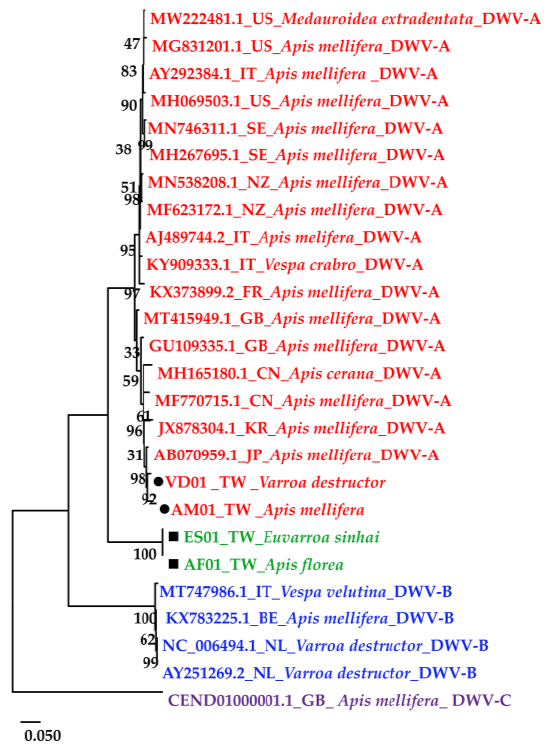
Figure 3. Maximum-likelihood phylogenetic tree (Tamura-Nei model; 1000 replicates) constructed based on the RdRp region sequence of four isolates in this study; the 22 DWV-associated strains and complete genome were from the NCBI database. Table 5. Percentage nucleotide and amino acid sequence’s identity in an alignment between 243 isolate from Apis florea , three genotypes, and other isolates in this